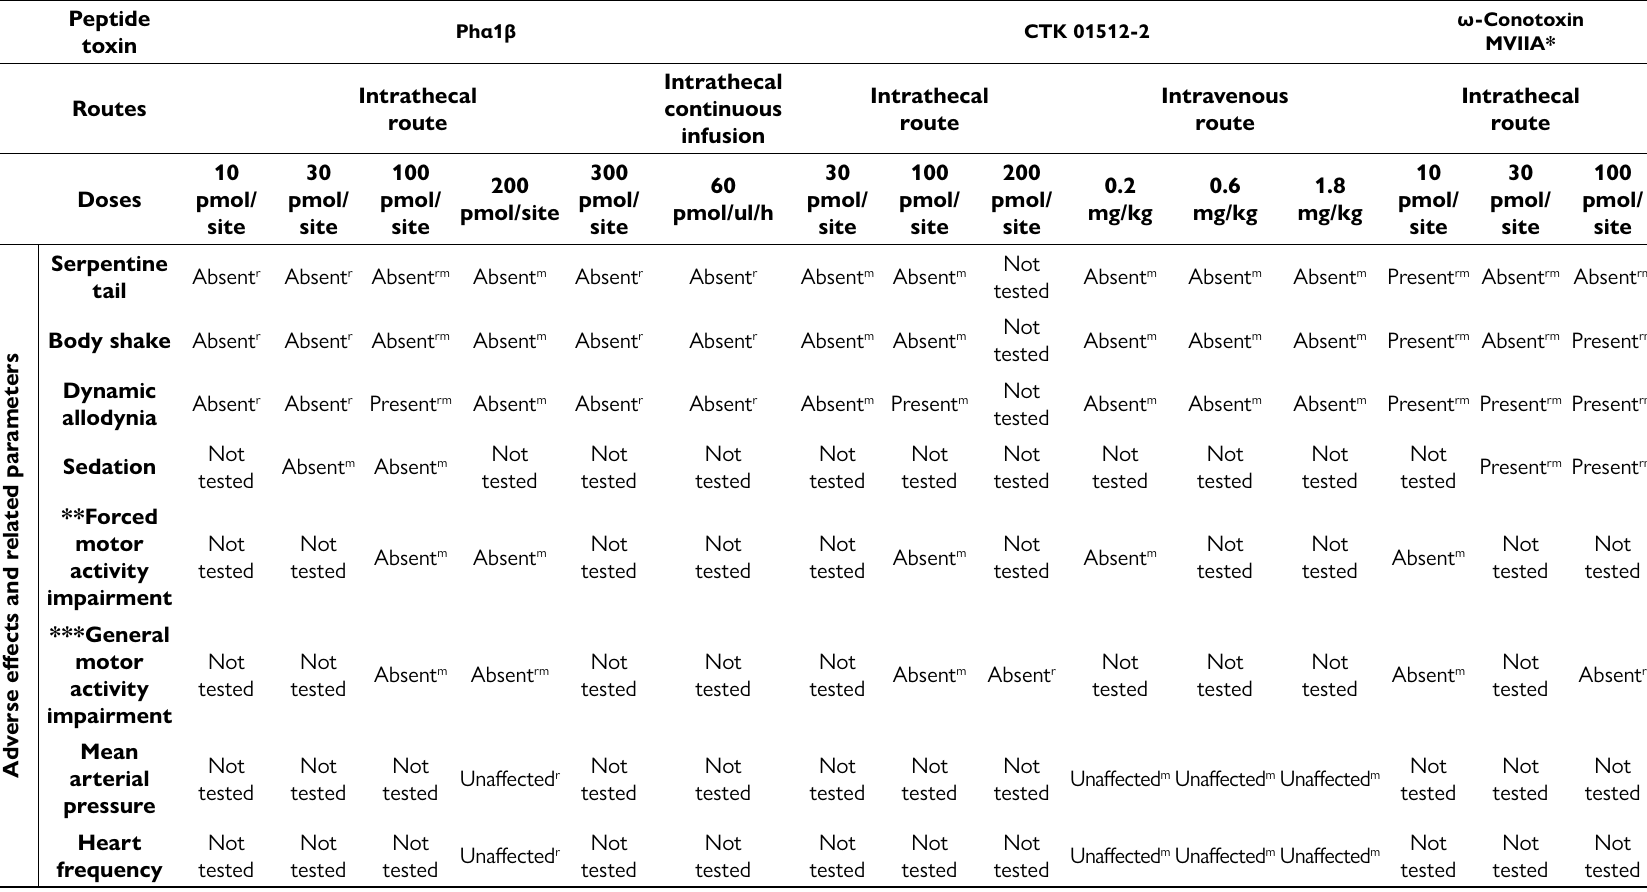
Table 2. Side effects of Phα1β, CTK 01512-2 and ω -conotoxin MVIIA (Ziconotide, Prialt®) in different doses or administration routes. Peptide